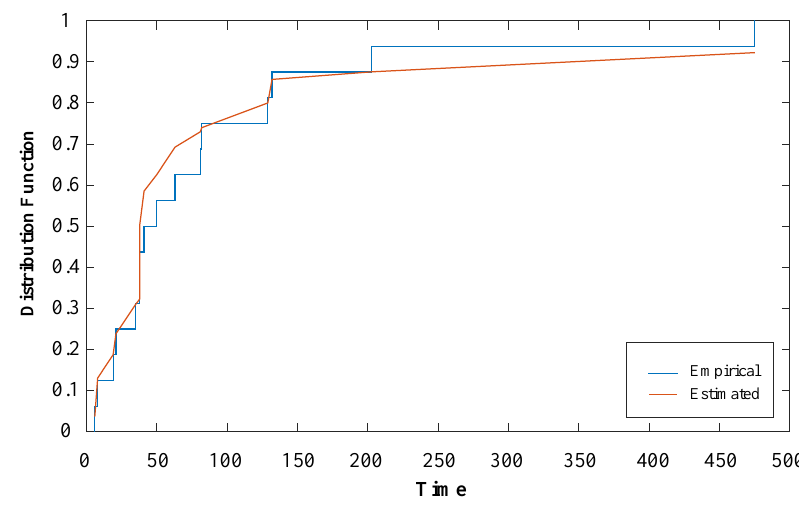
Figure 3. Distribution function of the EME model for AMC data.